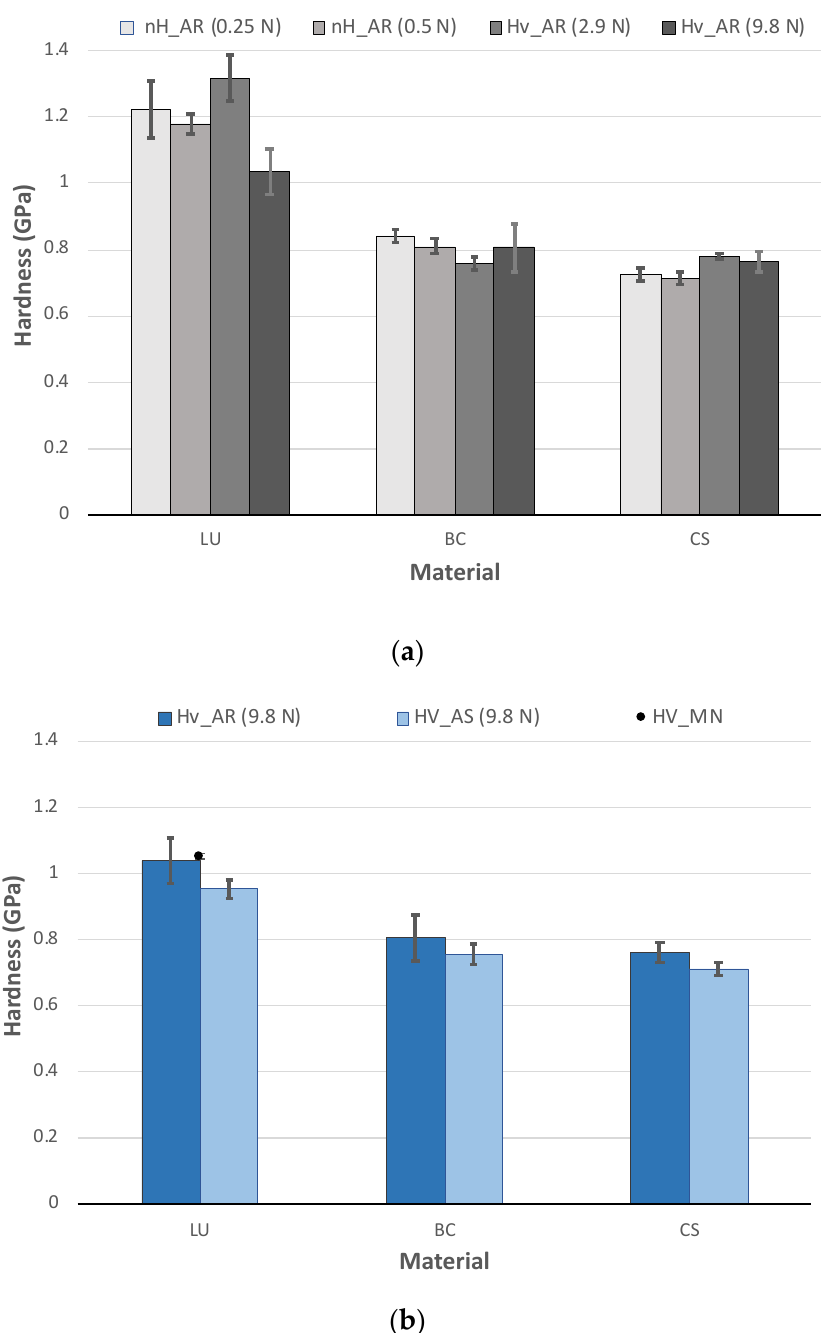
Figure 6. Micro and nanohardness (mean and standard error) ( a ) Influence of the applied load and the test method on the received from manufacturer (AR) specimens; ( b ) Influence of the artificial saliva (AS) immersion and the comparison with the manufacturer (MN) data.